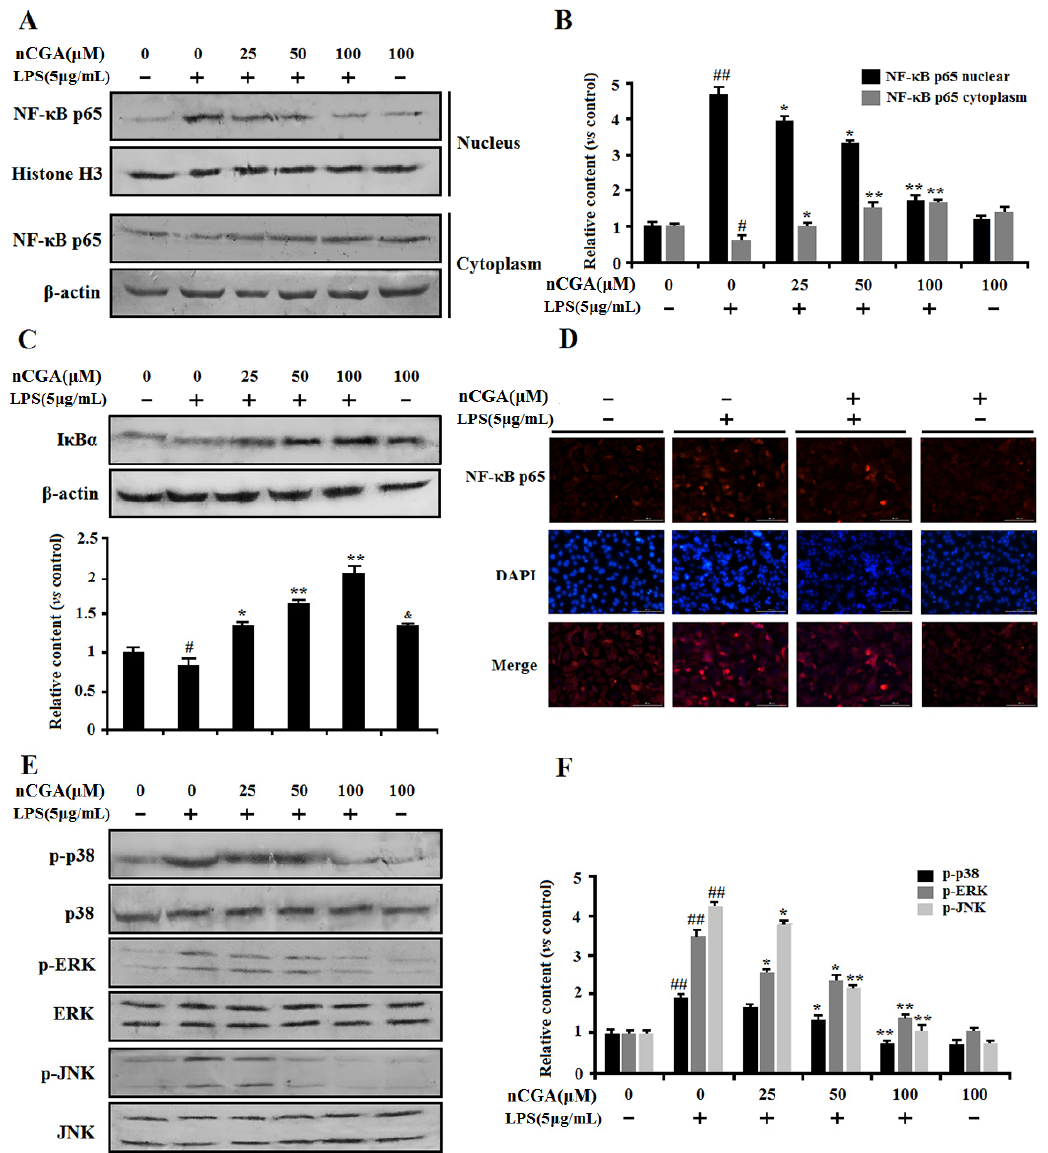
Figure 4. E ff ects of nCGA on the NF- κ B and MAPK signaling pathway in A549 cells. Cells were pretreated with or without various concentrations of nGCA (0, 25, 50, 100 µ M) for 2 h before LPS (5 µ g / mL) stimulation for another 6 h. ( A , B ) nCGA inhibited the NF- κ B activation, the level of NF- κ B p65 in the nucleus and cytoplasm were detected using Western blot analysis. ( C ) Western blot analysis showed the protein expression levels of I κ B. ( D ) To verify the above results, the expression of the NF- κ B p65 subunit in the nucleus was measured using immunofluorescence assay (NF- κ B p65 subunit and nuclei were viewed red and blue, respectively). ( E , F ) The expression of total p38, ERK, JNK, and phosphorylation were detected by Western blot analysis. The values represent the mean ± SD of three independent experiments, significant di ff erences between di ff erent groups. # p < 0.05, ## p < 0.01 vs. control group, * p < 0.05, ** p < 0.01 vs. LPS alone, & p < 0.05, nCGA treated group vs. control group.